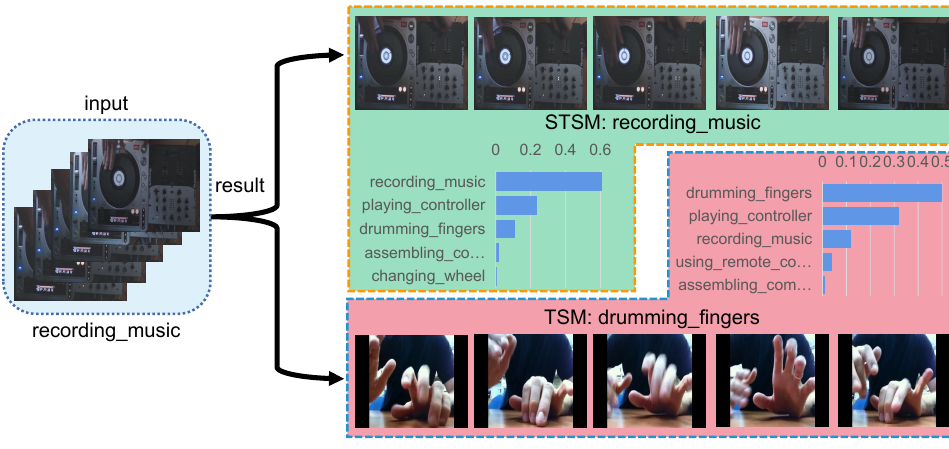
Figure 7. The top five results of STSM and TSM of the recording music